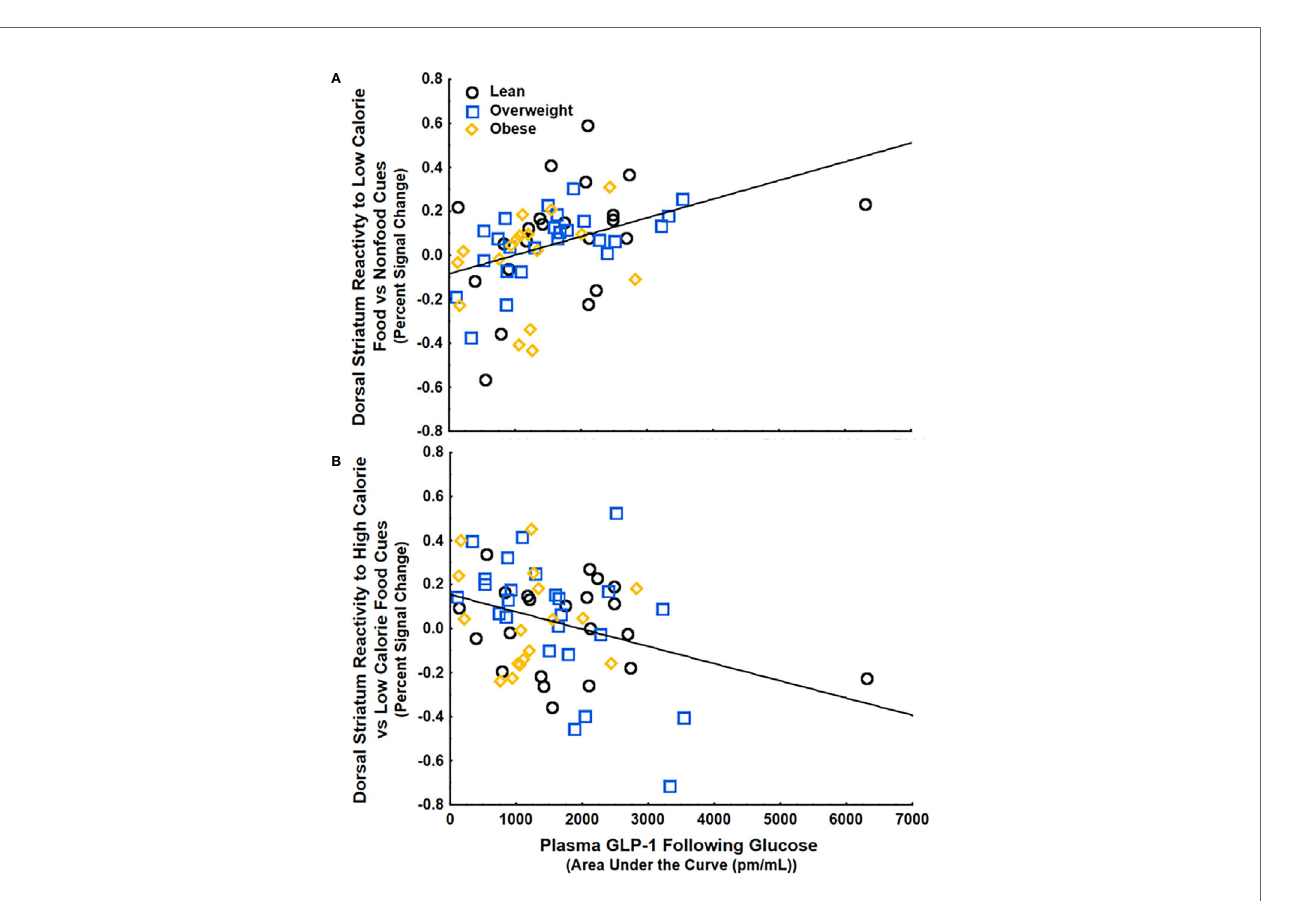
FIGURE 3 | GLP-1 secretion following glucose ingestion was (A) positively correlated with striatal food cue reactivity to low-calorie food vs nonfood cues (p<.01) and (B) negatively correlated with striatal food cue reactivity to high-calorie relative to low calorie food cues (p<.05). These fi ndings were controlled for BMI, percent calories from added sugar, age, and gender.